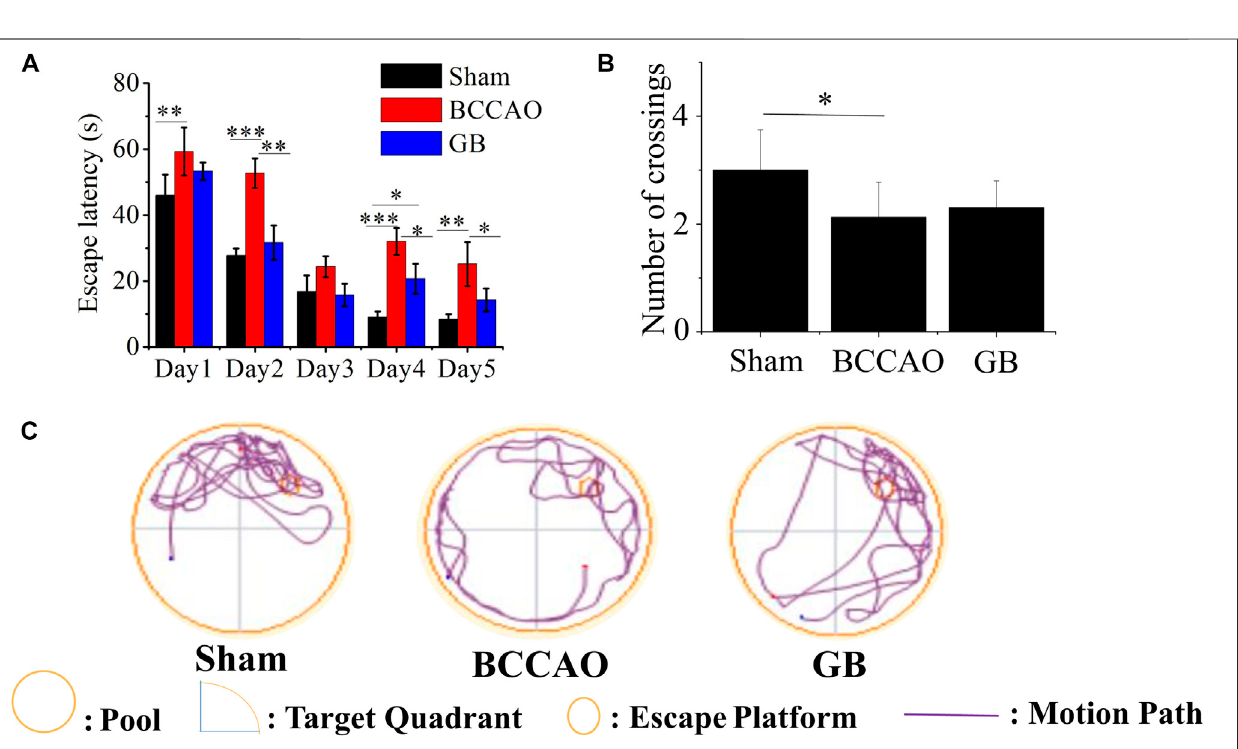
FIGURE5| EffectsofGBonimprovingspatiallearningandmemoryinBCCAOrats (A) Escapelatenciesanalysis.Datarepresentedthemean ± SD( n (cid:1) 5),* p < 0.05,** p < 0.01, *** p < 0.001 (B) Theplatformcrossingnumberin thespatialprobetest. Datarepresented themean ± SD ( n (cid:1) 5),* p < 0.05 (C) Mapping ofswimminglocation ofratsin watermaze.